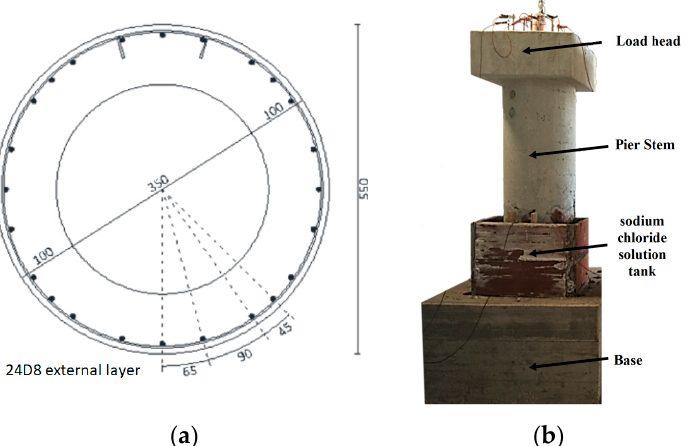
Figure 2. ( a ) Cross section (dimensions in mm) and ( b ) frontal view of circular hollow pier with sodium chloride solution tank.